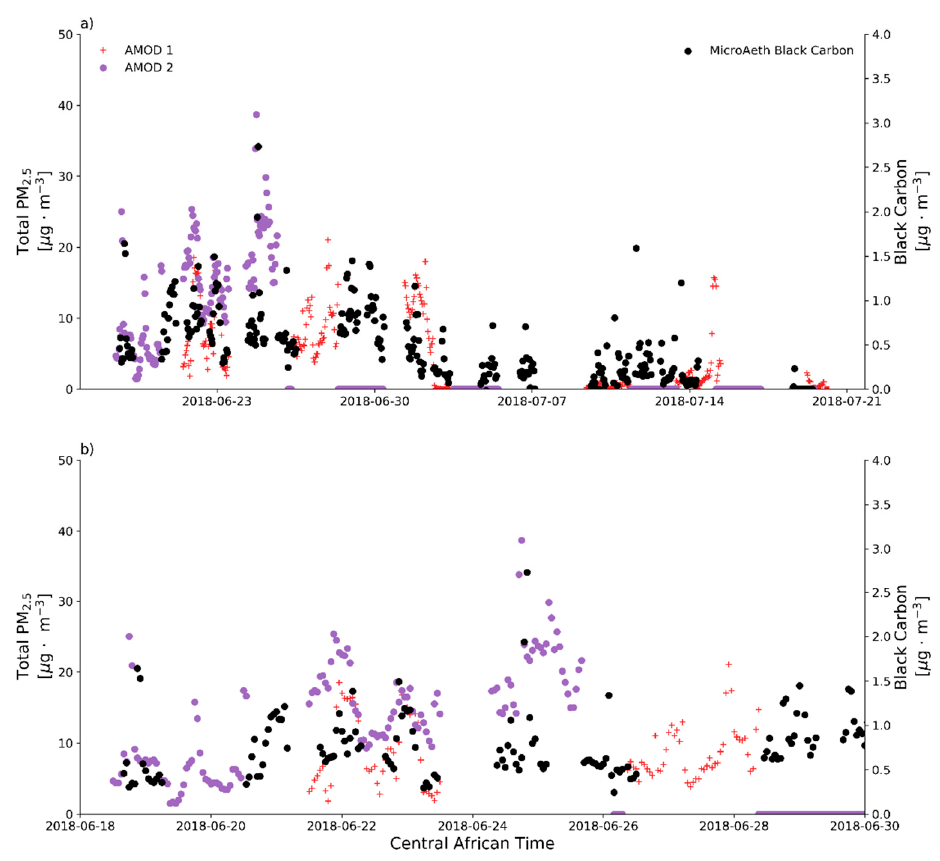
Figure 6. Time series of plantower PM 2.5 and black carbon ( a ) for the entire time period and ( b ) zoomed in on the first half of the time period, where a regular diurnal cycle is present.